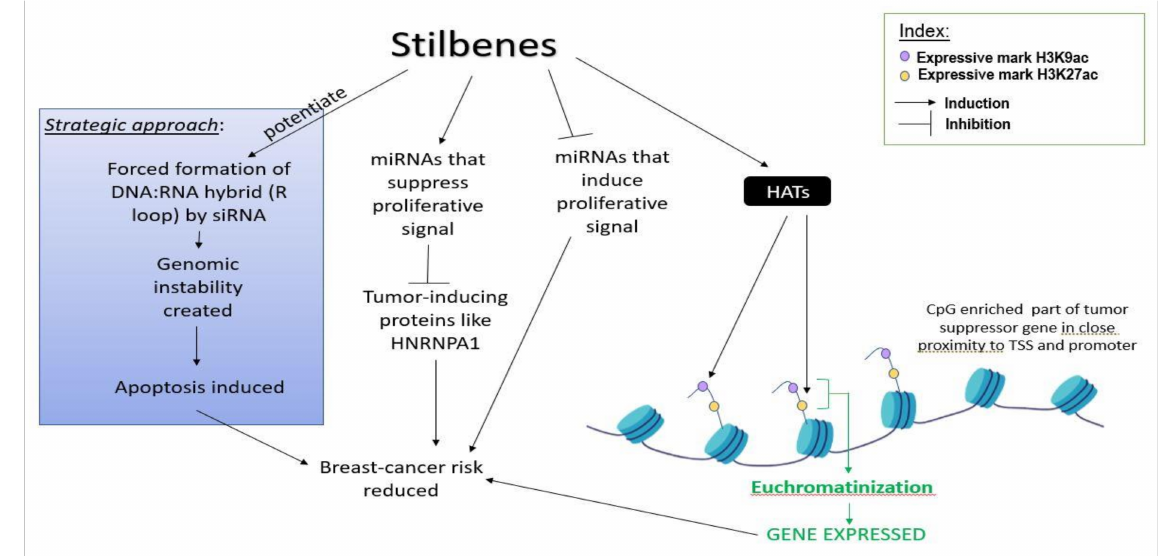
Figure 4. Schematic representation of the mechanisms involved in the expression of TSGs and the role of the stilbenes involved in this